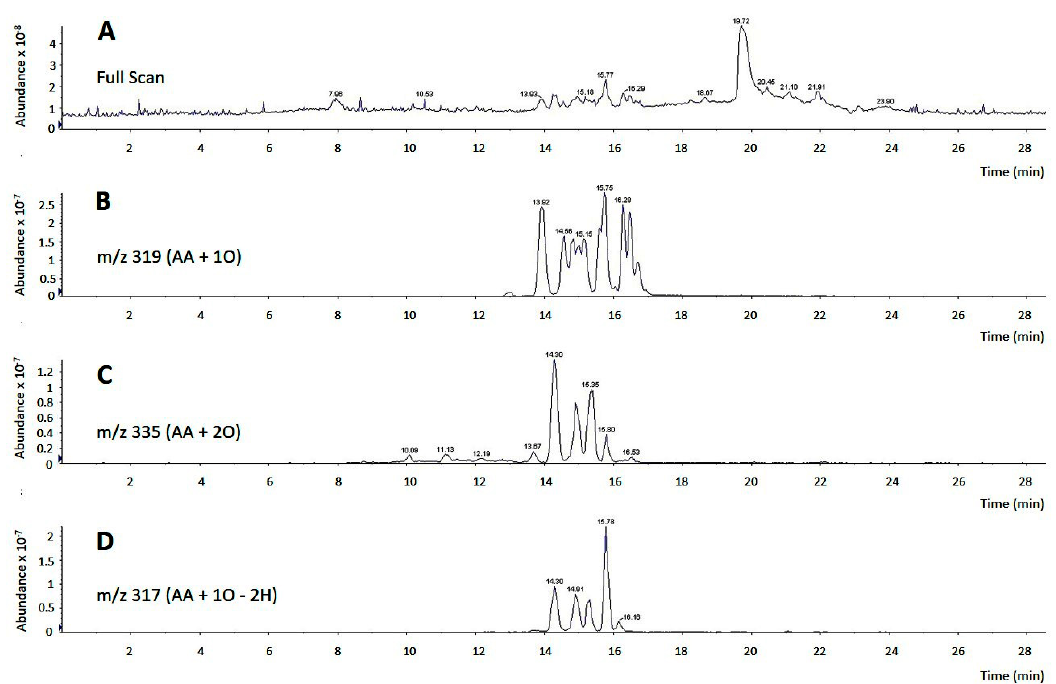
Figure 2. LC / MS analysis of commercial AA. ( A ) Full scan chromatogram of a commercial AA sample, showing a major peak at 19.72 min, representing pure, non-oxidized AA, and groups of peaks between 13.93 min and 16.53 min, representing multiple oxidized AA derivatives; ( B – D ) analyses of oxidized derivatives of commercial AA. In panel B, m / z 319 was selected to detect arachidonate hydroxides and